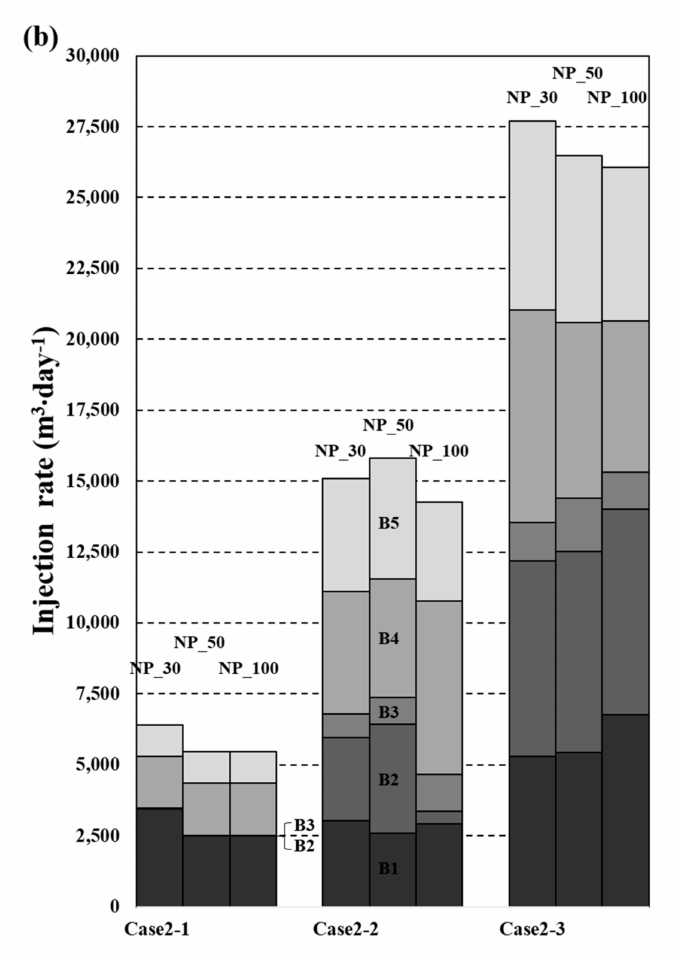
Figure 12. The averaged results from six times of repeated optimization processes for each different population size in the management Scenario